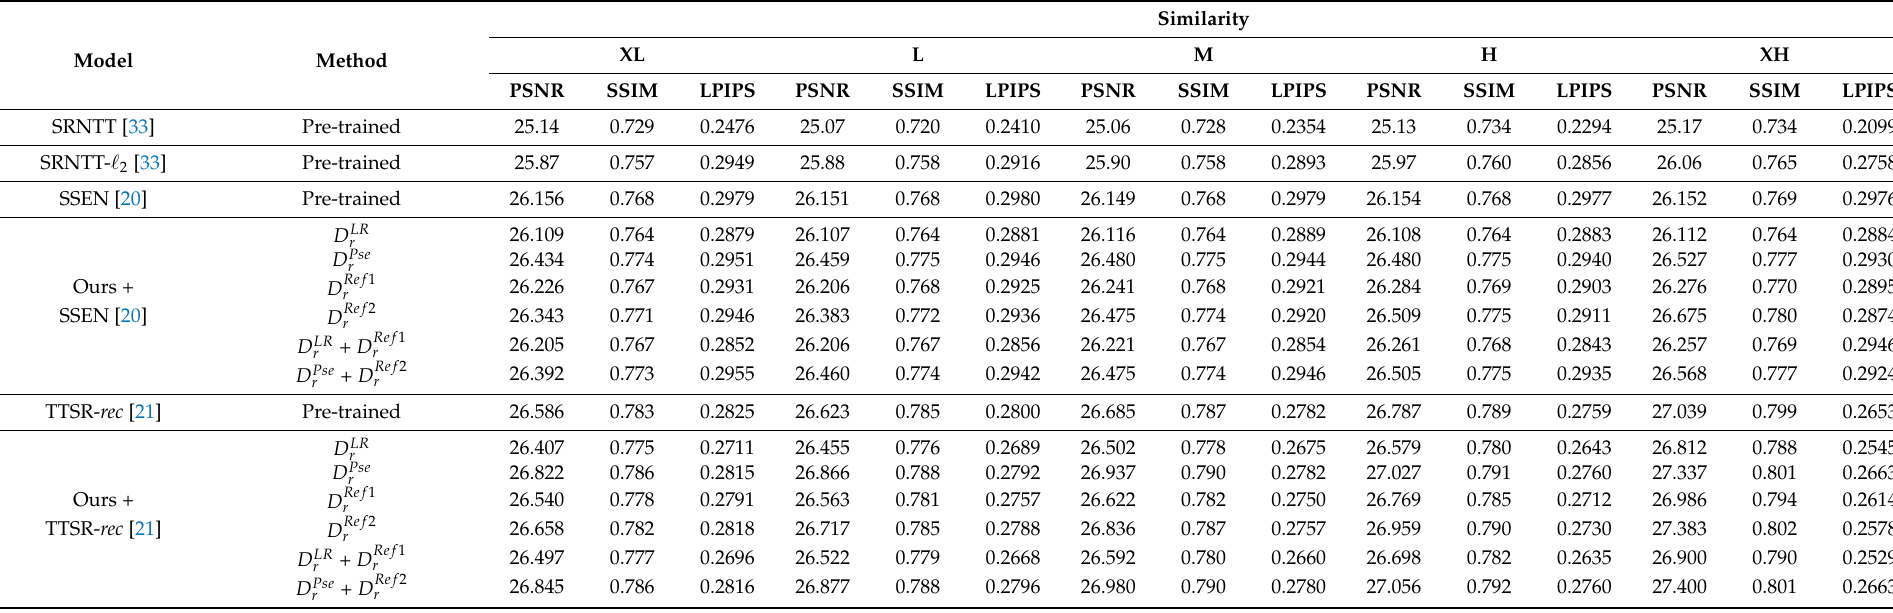
Table 4. RefSR online learning results on RefSR